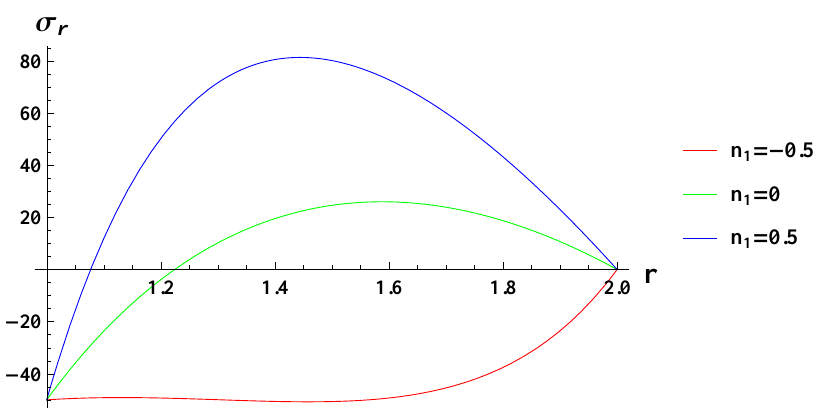
Figure 3. Radial stress (in MPa) along the radius r (in cm) of the cylinder, under the effect of rotation ( ω 2 = 50 rad/s), internal pressure p i = 50 MPa and exponential volume reinforcement.